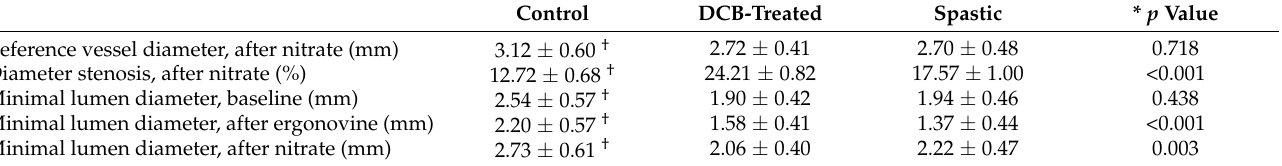
Table 2. Angiographic characteristics of the analyzed 274 coronary arterial segments.